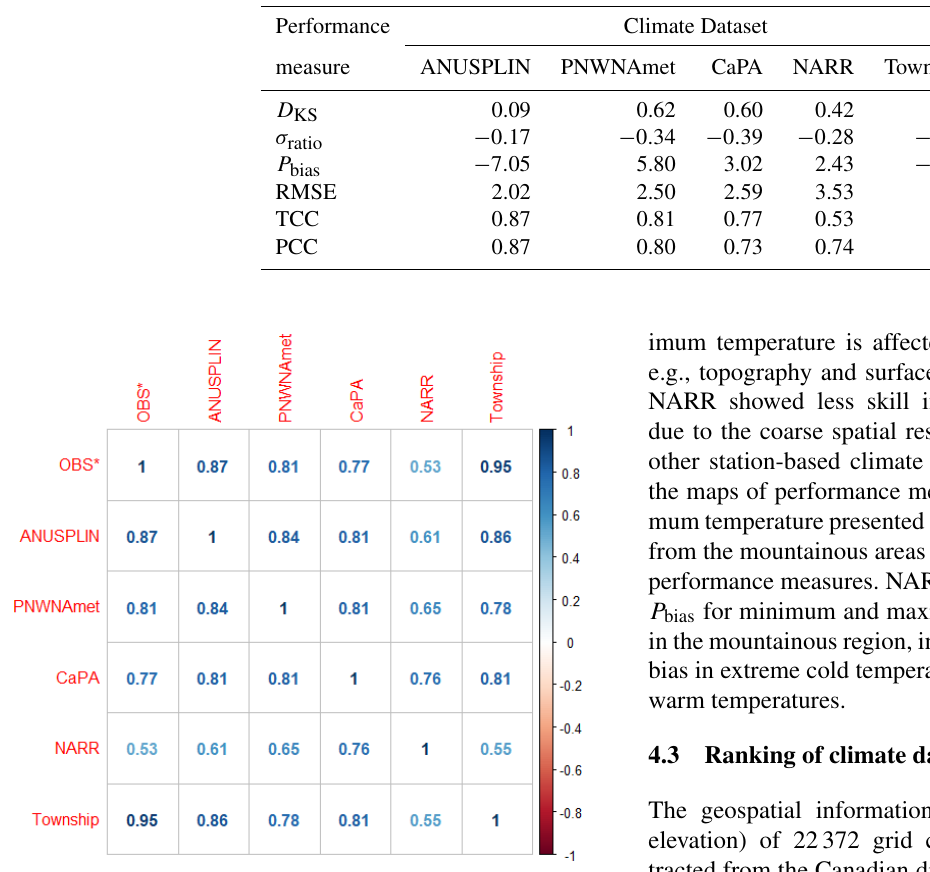
Figure 4. Temporal correlation coefficient (TCC) between histori- cal precipitation data. ∗ AHCCD